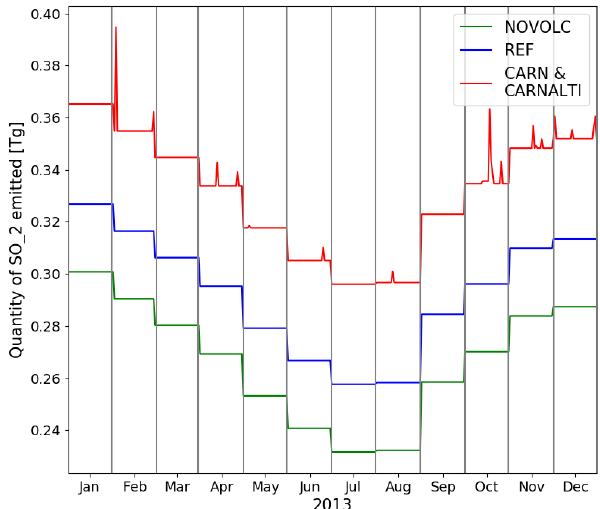
Figure 1. Temporal evolution of 2013 SO 2 emissions in Tg, the non-volcanic emissions inventory for NOVOLC, plus the Andres and Kasgnoc (1998) volcanic emissions inventory in REF or the Carn et al. (2016, 2017) volcanic emissions inventory in CARN and